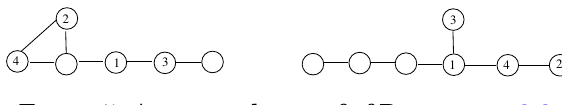
Figure 5: A step in the proof of Proposition 2.3.